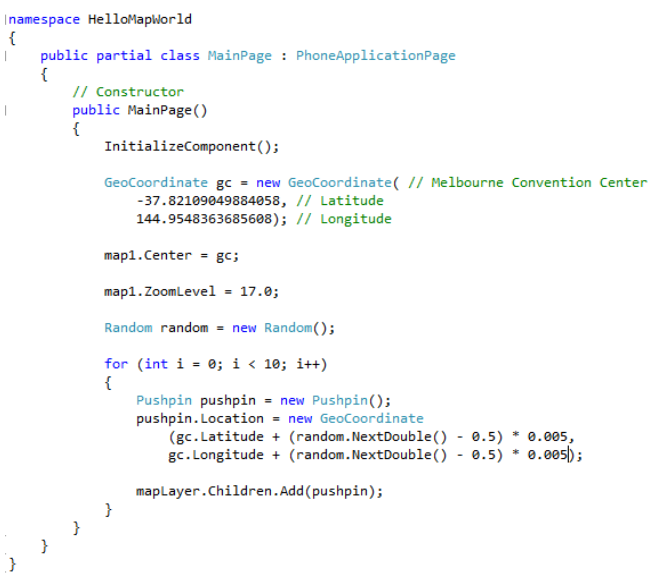
Source Code to Draw Pushpins on Map